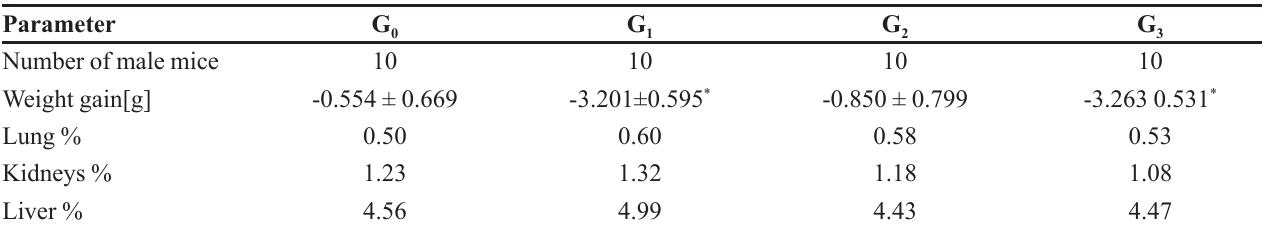
TABLE I - Parameters related to male mice toxicity Parameter